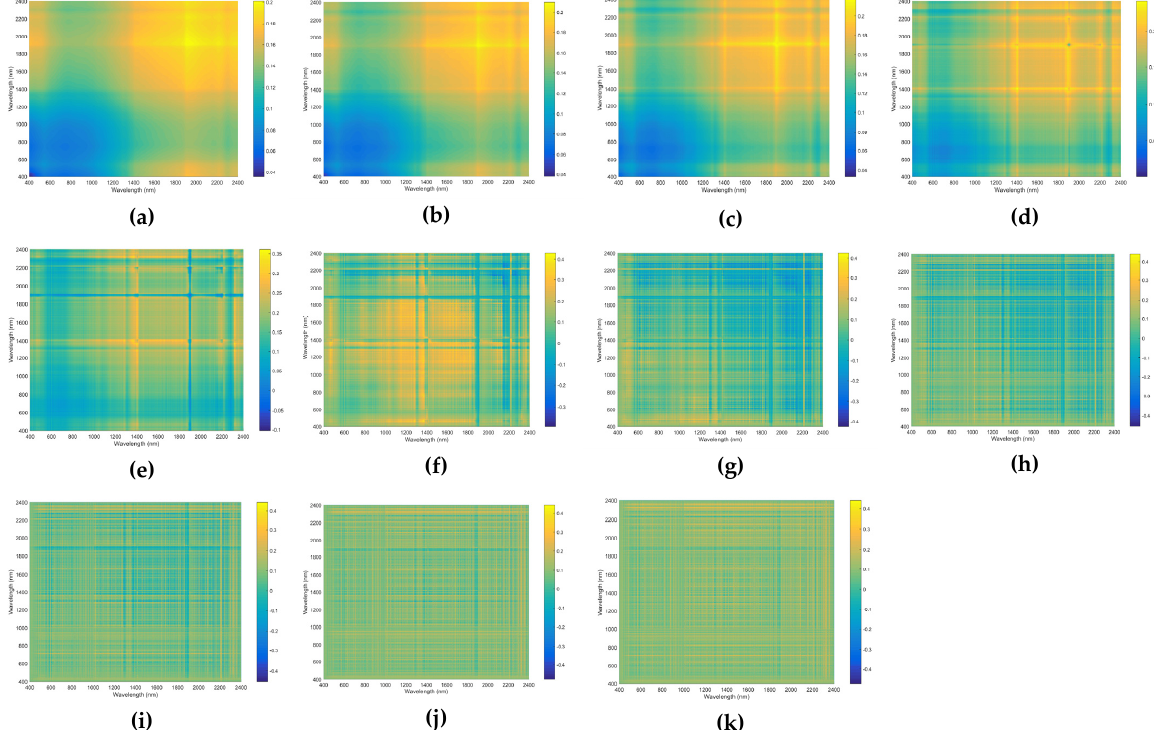
Figure A5. Correlation coefficients between soil Hg and sum index of the reflectance processed by ( a ) 0-order, ( b ) 0.2-order, ( c ) 0.4-order, ( d ) 0.6-order, ( e ) 0.8-order, ( f ) 1-order, ( g ) 1.2-order, ( h ) 1.4-order, ( i ) 1.6-order, ( j ) 1.8-order, ( k ) 2-order.